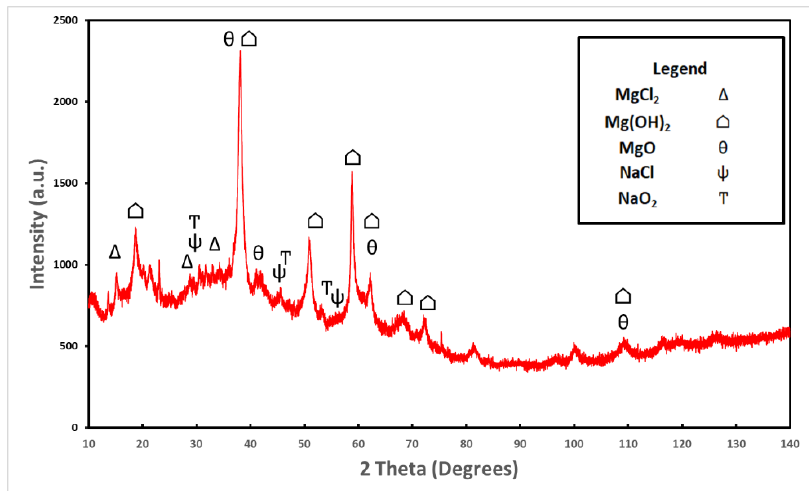
Figure 6. XRD analysis was performed on the hydrated oxide layer removed from the roughened sample. The dominant compound present was Mg(OH) 2 followed by MgO. Also present was NaCl, NaO 2 , and MgCl 2 in smaller quantities, most likely produced as a result of the corrosion taking place in the salt fog